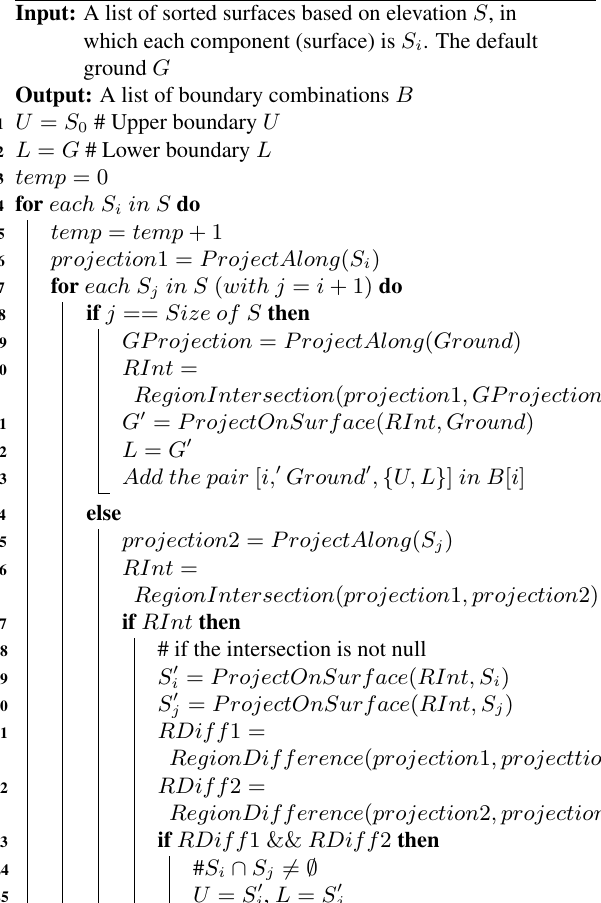
Algorithm 1: Upper and lower boundary